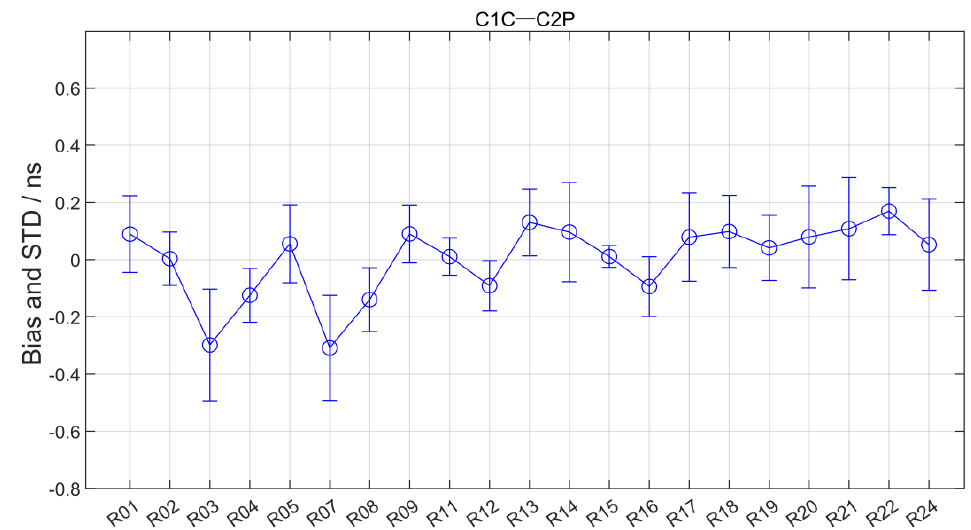
Figure 22. Comparison results between DCB and CAS products of GLONASS satellite.